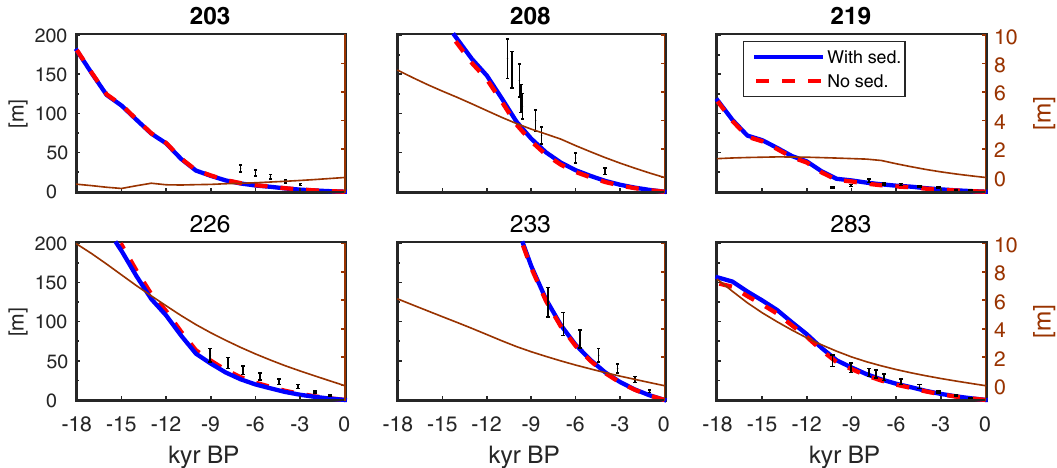
Figure 4. RSL at selected sites from the Tushingham and Peltier (1992) database, for the ICE-5G model (red dashed line) and the ICE-5G model with sediment transport (blue line) according to the Amantov model in combination with the M4-16-80 Earth model. The brown line shows the difference, with the scale on the right y